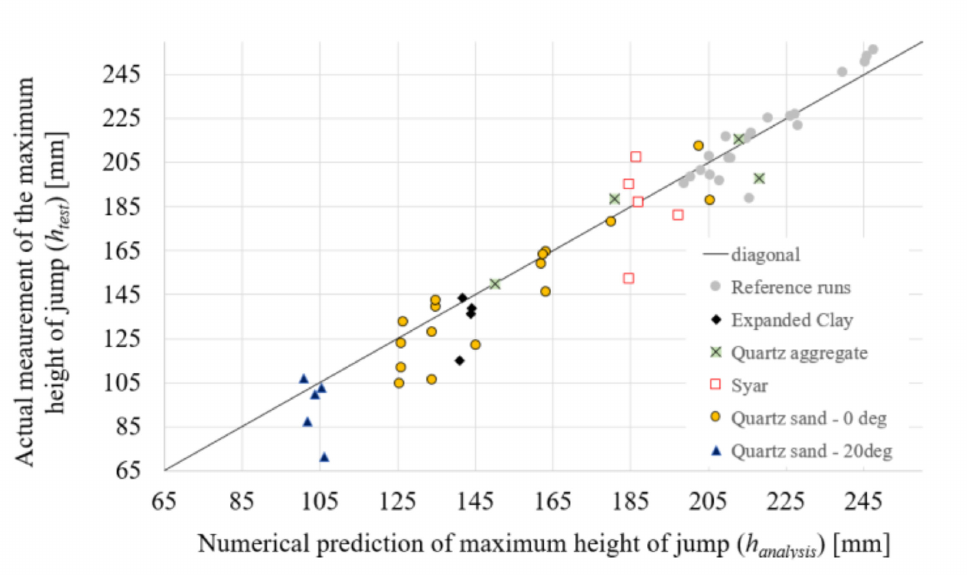
Figure 22. Test measurements ( h test ) compared to predicted height of jump from analysis ( h analysis